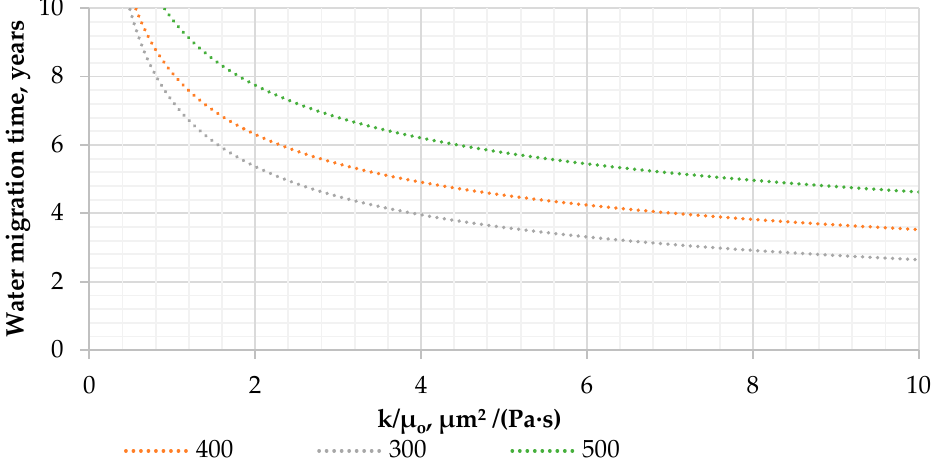
Figure 8. Dependence of the water migration time on the mobility factor (distances of 300, 400, and 500